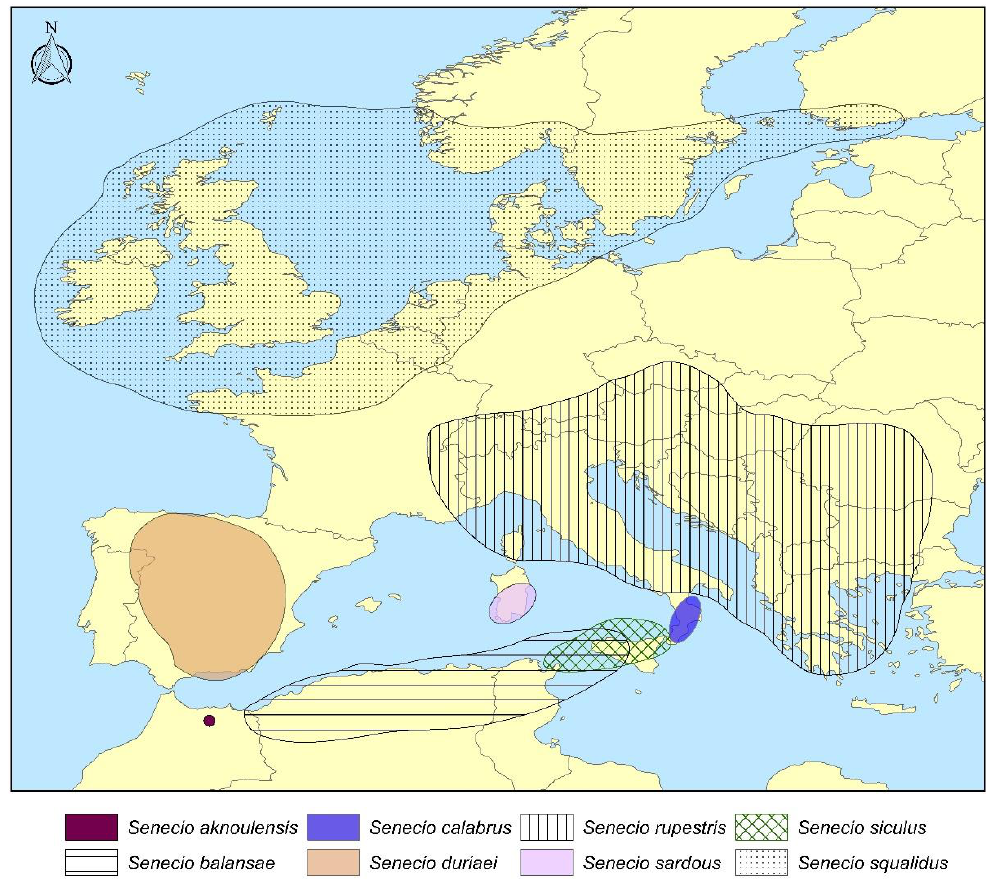
Figure 3. Overview distribution map concerning 8 out of the 10 species of the Senecio squalidus group.